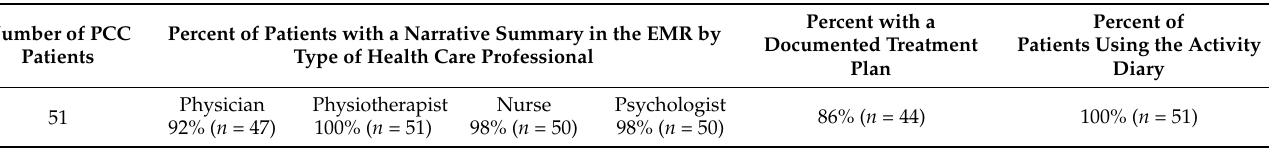
Table 1. Quantitative person-centered care (PCC) measures related to PCC implementation effectiveness in the pilot phase. EMR = electronic medical